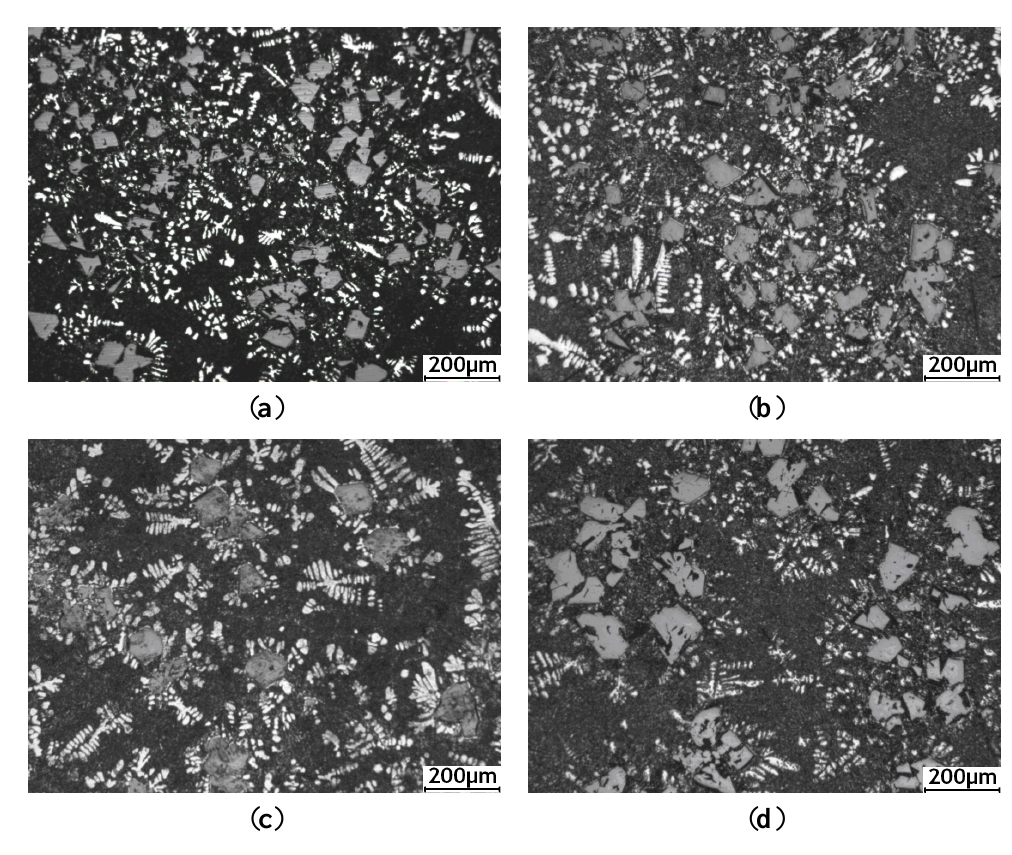
Figure 6. Optical micrographs of primary Si crystals in hypereutectic Al–20%Si alloy with 0.6 wt% Al–5Ti–C master alloy at different heat treatment times: ( a ) 30 min; ( b ) 60 min; ( c ) 90 min; and ( d ) 120